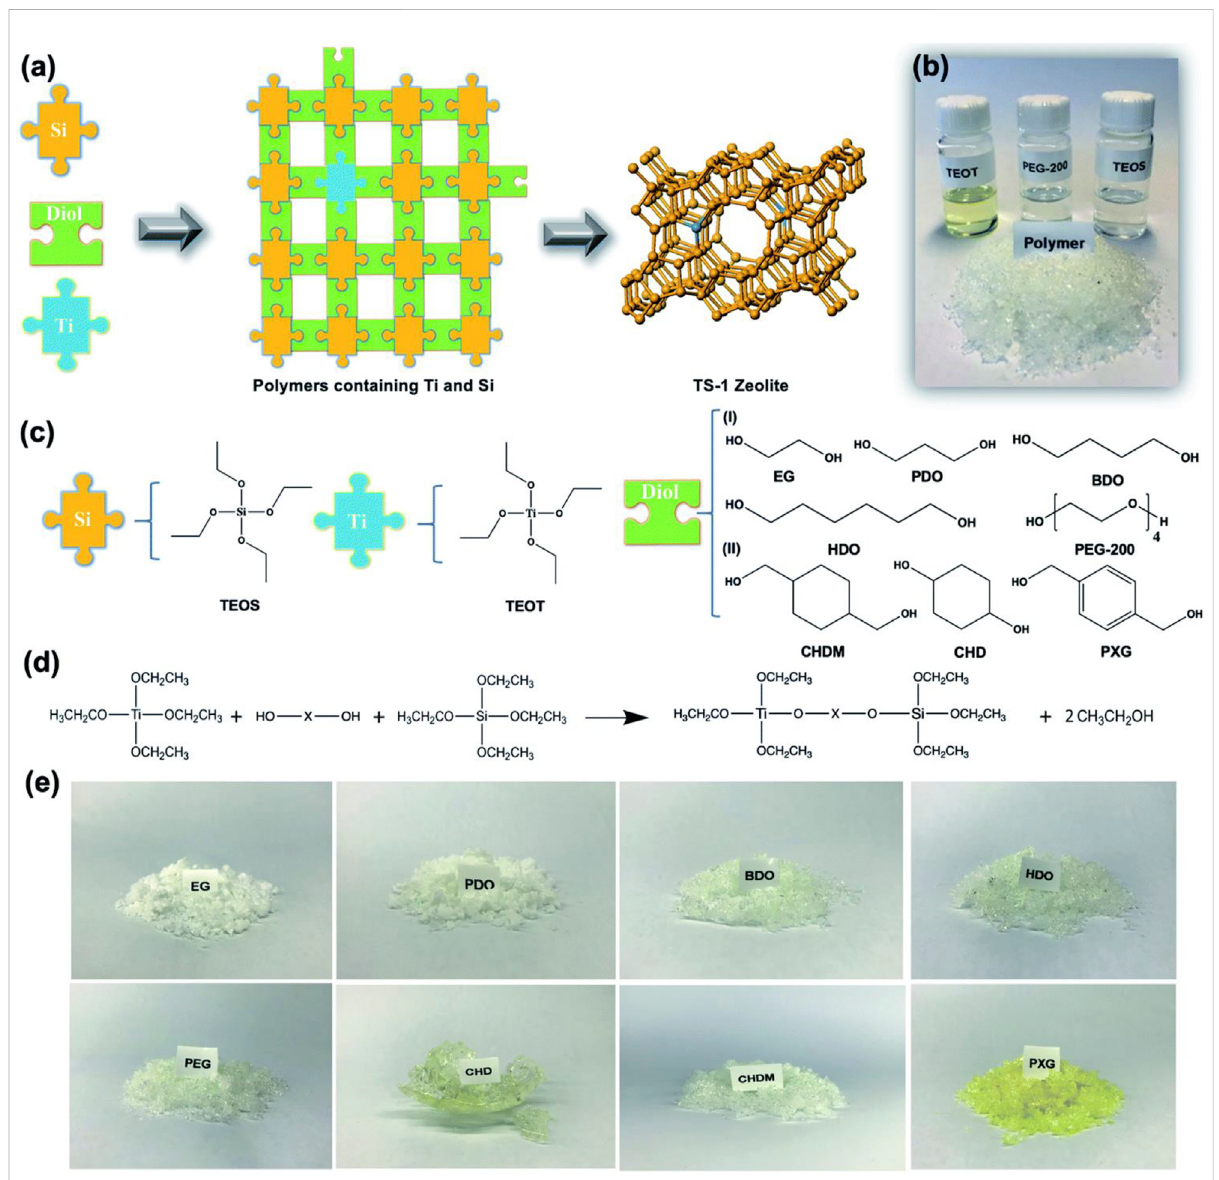
FIGURE 1 (A) Synthesis of TS-1 zeolite from Ti – diol – Si polymers. (B) Photograph of the liquid raw materials and solid polymer products. (C) Types of alkyl titanates, alkyl silicates and alkyl diols used. (D) Transesteri fi cation reaction. (E) Photograph of the Ti – diol – Si polymers. Reprinted with permission from Xing et al. (2021). Copyright 2021 Royal Society of